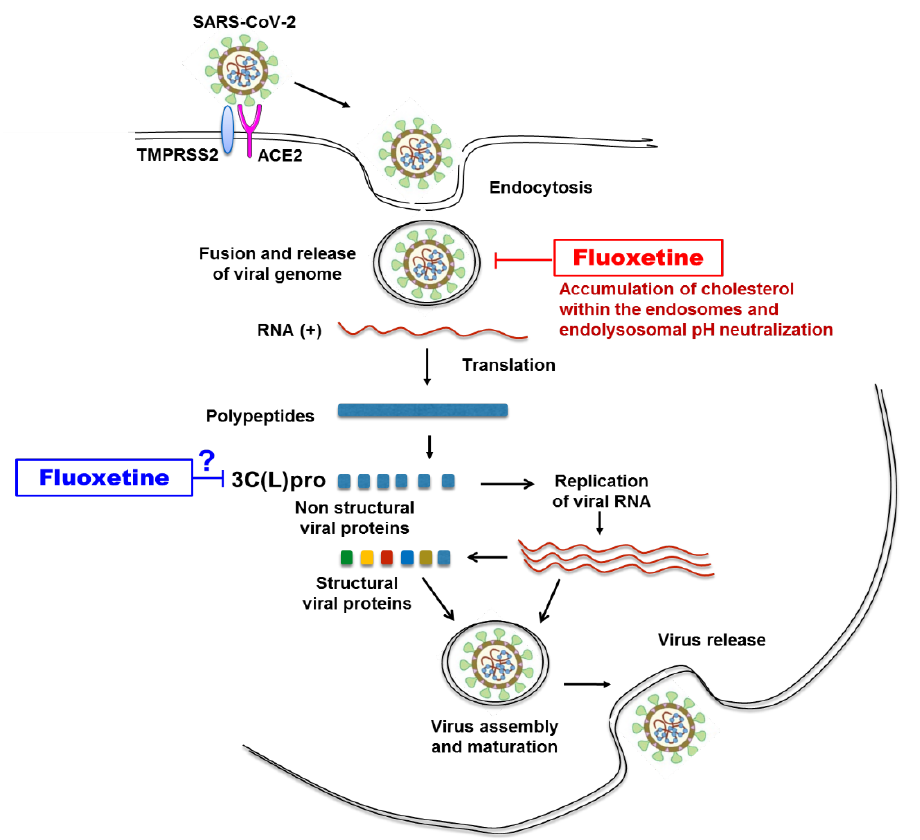
Figure 4. Antiviral activity of fluoxetine: known or potential targets of fluoxetine in steps of SARS-CoV-2 replication in permissive cell.